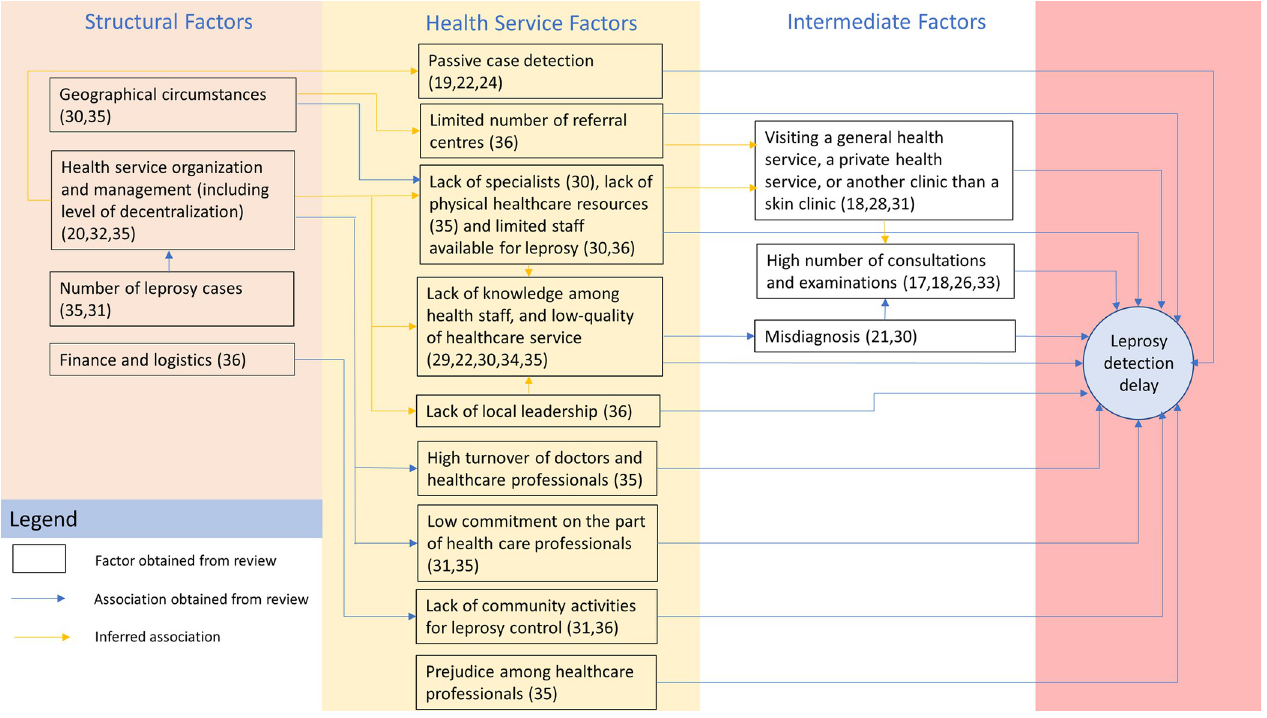
Fig 2. The framework of healthcare factors related to leprosy case-detection